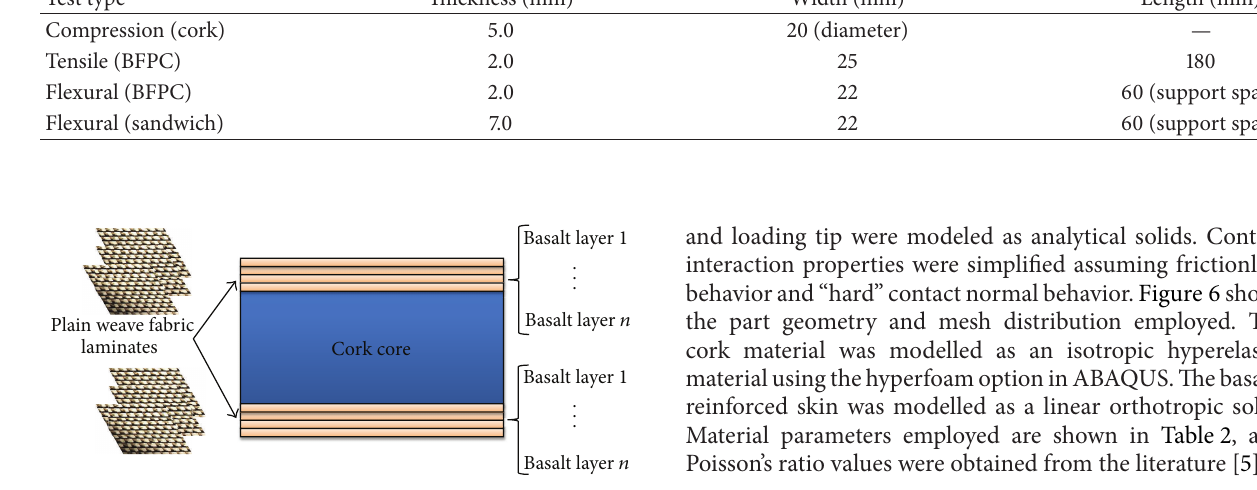
Figure 4: Composite sandwich structure